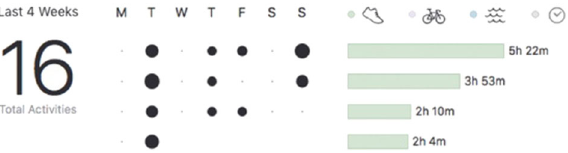
Fig. 3 Personal statistics. A section of a Strava user ’ s dashboard, showing an overview of the frequency and length of their runs in the last 4 weeks. Reproduced with permission from